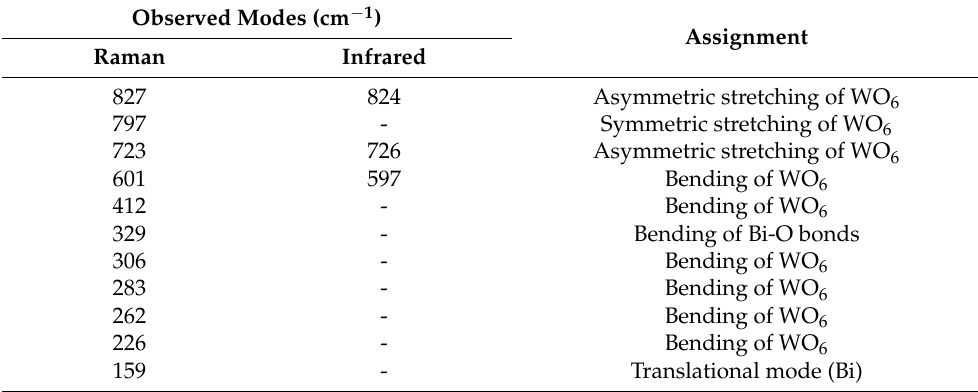
Table 2. MIC of layered Bi 2 WO 6 nanosheets.